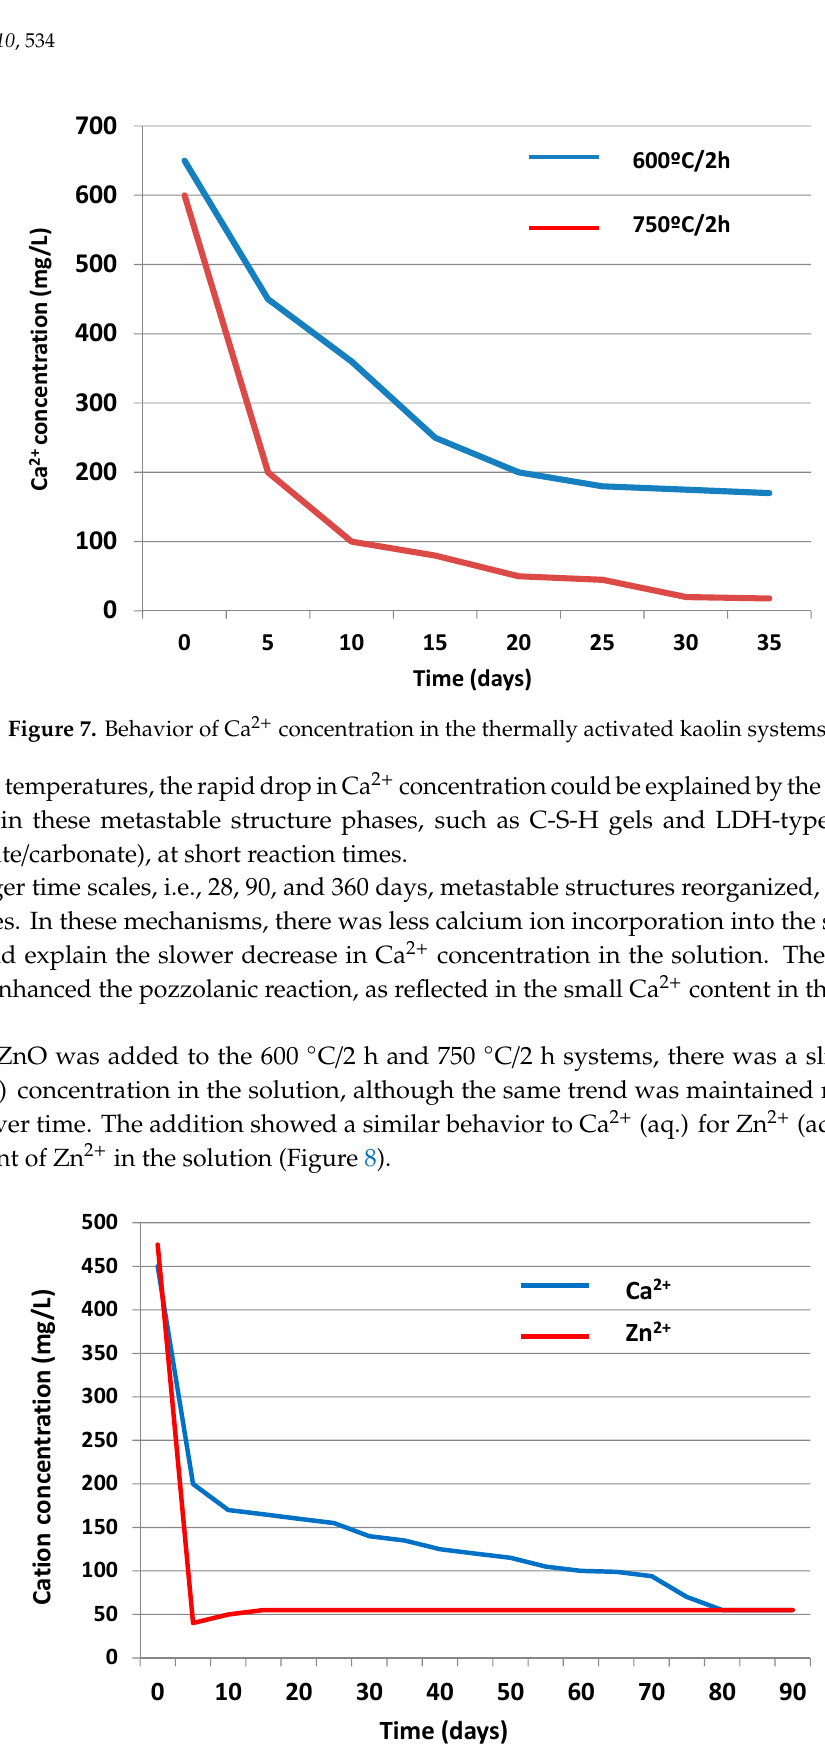
Figure 8. Behavior of Ca 2+ and Zn 2+ concentrations in the kaolin system activated at 600 °C/2 h.